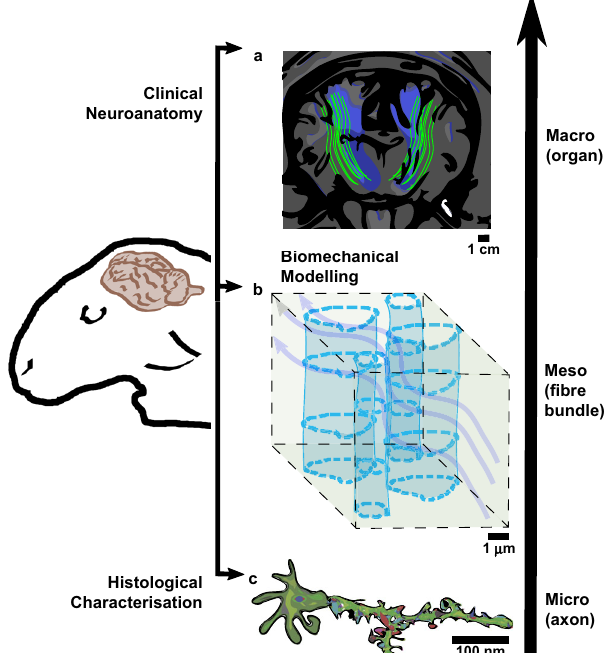
Fig. 1 Different length scales of interest exist within the scienti fi c research community. a Typical clinical images, such as the tractography 107 , give a broader fi eld of view to clinicians. Medical research is interested in the macro-organization of the WM as via these images the diagnosis, surgical planning and the overall assessment of the brain can be studied and achieved. b At the intermediate length scales, microstructural information can be obtained to reconstruct axonal structures, aiming at a fi nal accurate geometrical characterization of a Representative Volume Element (RVE), which can be used to shed light on fundamental aspects of tissue biomechanics, e.g. mechanical 9 and fl uid dynamics 108 , or material mimicking studies 109 . c At the smallest scales 3D reconstructions of individual axons 103 can be performed, which give a detailed representation of how the axons appear in grey matter: branching of the axons, synaptic buttons and dendritic spines can be easily distinguished, aiding the histological understanding and description up to the fi nest detail of neuronal bodies. However, these two categories of data either miss the simpli fi cation needed by the bioengineering community or lack the length scale of investigation that are fundamental to relate the stiffness of the tissue to its structure at the length scale of the myelinated